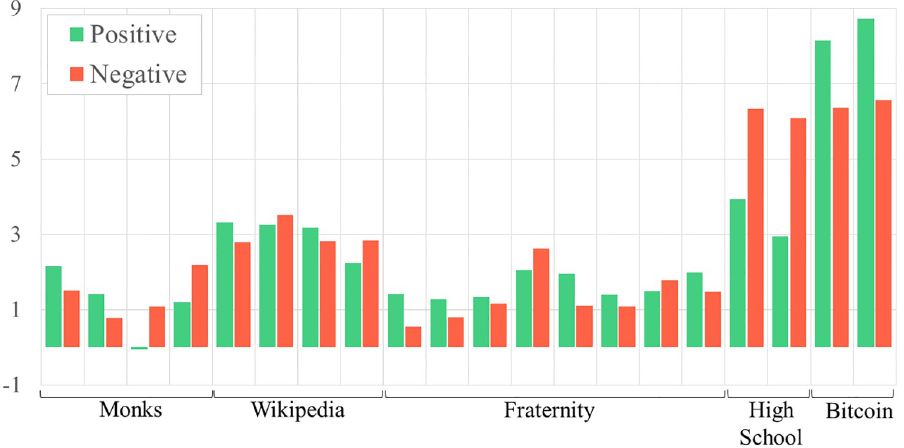
Fig 2. Reciprocity ERGM coefficient values for positive versus negative networks grouped by network